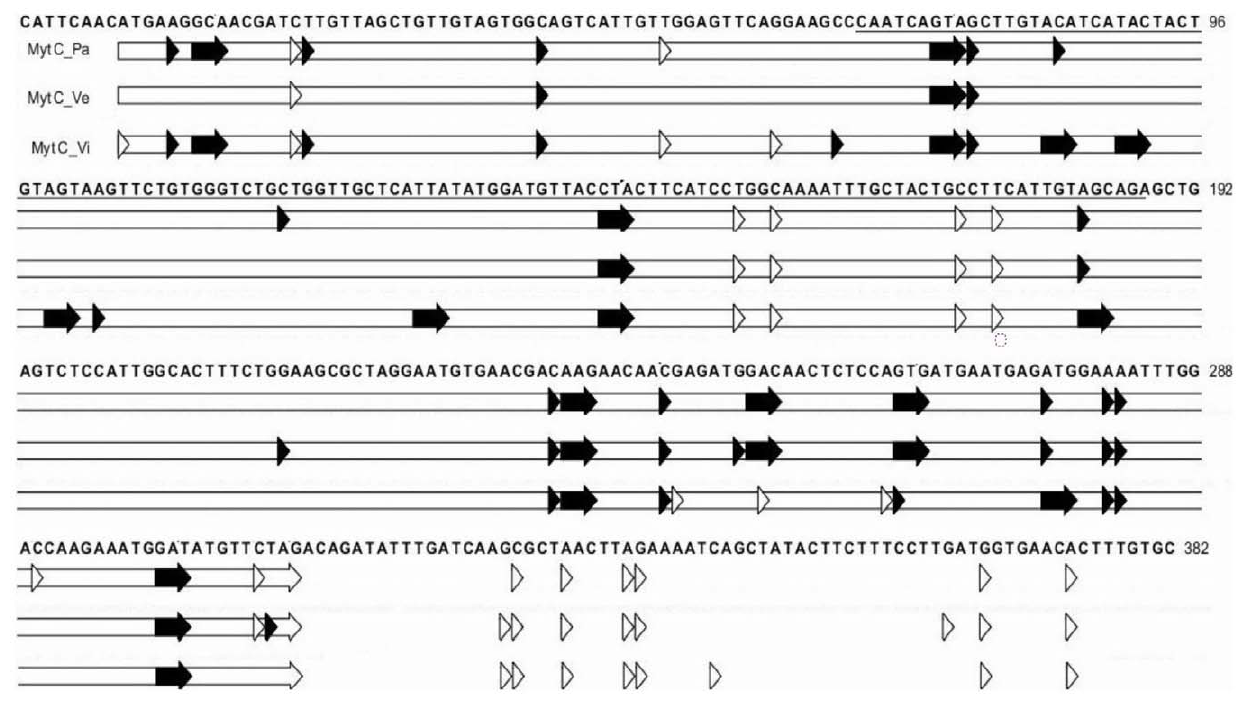
Figure 5. SNCs mapped along the MytC sequence in the Pa, Ve and Vi samples. Synonymous (empty) and non-synonymous (filled) changes are located on the AMP precursor sequence. Empty horizontal bars indicates cds, mature peptide sequence is underlined.